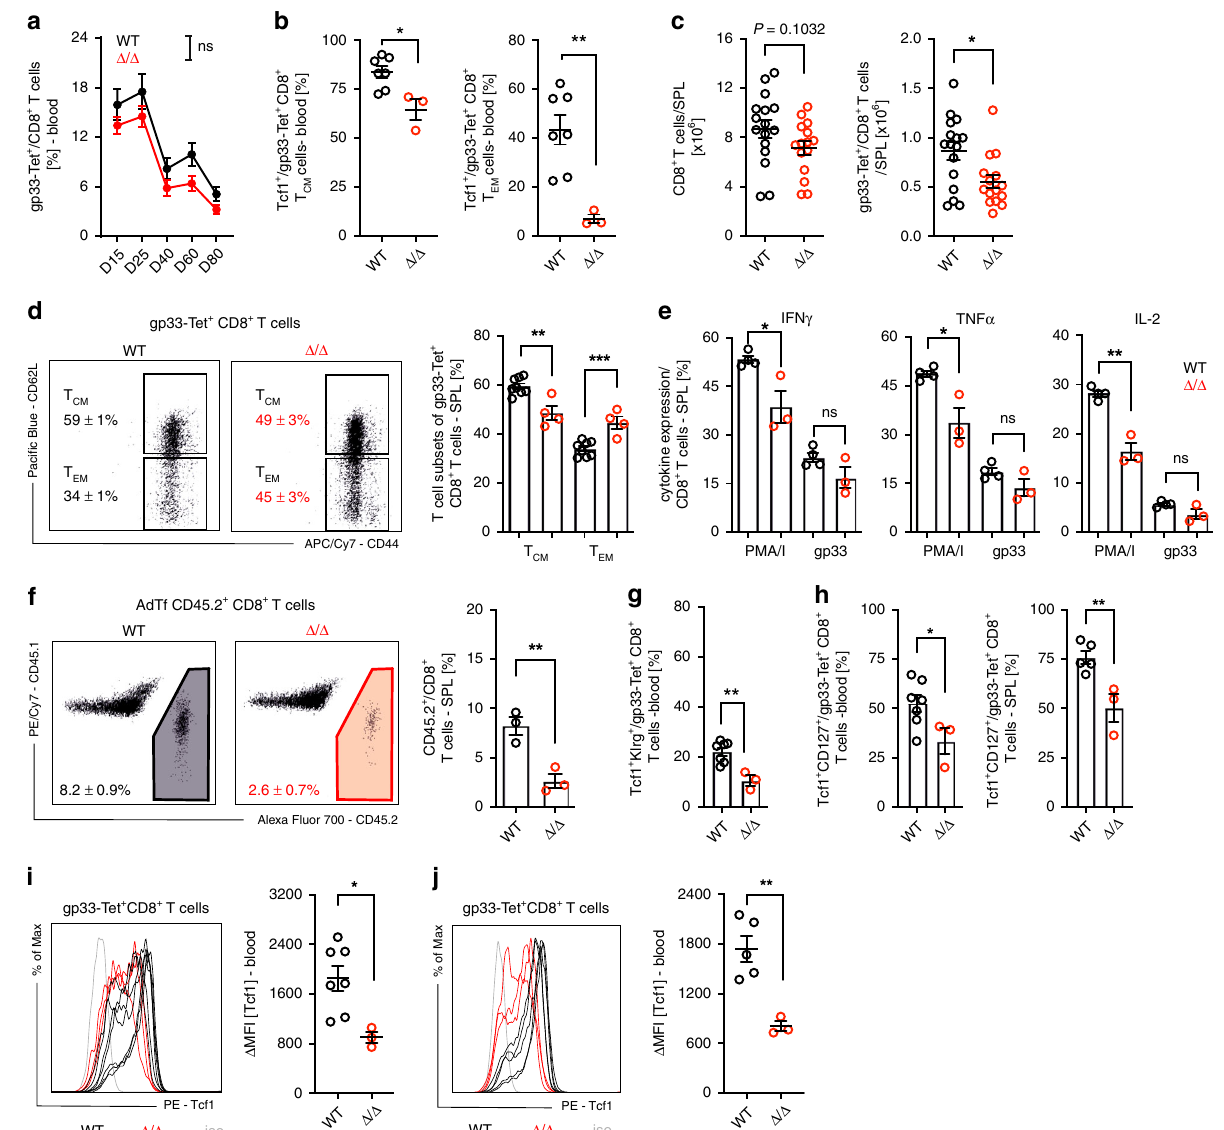
Fig. 2 Deletion of Tnik before priming impairs CD8 + T-cell memory formation. a Gp33-Tet + CD8 + T-cell frequency in blood of 200 pfu LCMV-WE- infected Tnik WT and Tnik Δ / Δ mice. b Frequency of Tcf1 expressing T CM (CD44 + CD62L + ) and T EM (CD44 + CD62L − ) gp33-Tet + CD8 + T cells in blood on day 30 p.i. Mice were killed on day 90 p.i. c CD8 + T cells and gp33-Tet + CD8 + T cells in the spleen. d Dotplots and bar graphs showing distribution of gp33-Tet + CD8 + T CM and T EM cell subsets in the spleen. e Frequencies of INF γ , TNF α , or IL-2-producing CD8 + T cells after re-stimulation with PMA/ Ionomycin or gp33 peptide. f AdTf of 3 × 10 4 FACS-puri fi ed gp33-Tet + CD8 + T cells from spleens of day 90 memory mice ( Cd45.2 + ) injected into congenic recipient mice ( Cd45.1 + ) prior to reinfection with 200 pfu LCMV-WE. Dotplots and bar graphs show relative distribution of endogenous vs AdTf CD8 + T cells 4 days p.i. Frequencies of Tcf1 + Klrg + and Tcf1 + CD127 + per gp33-Tet + CD8 + T-cell subsets in blood or spleen ( g ) 4 days or ( h ) 38 days post rVV-G2 re-challenge. i , j Histogram and Δ MFI of Tcf1 expressing gp33-Tet + CD8 + T cells in blood and spleen day 38 post re-challenge. Depicted: Tnik WT (black lines/circles), Tnik Δ / Δ (red lines/circles), isotype controls (iso; gray lines). a , d – f Data are representative for one out of two independent experiments ( n = 3 – 4), c for three pooled independent experiments ( n = 15 – 16), b , g – j for one experiment ( n = 3 – 7). Data are displayed as means ± SEM. Statistics: a two-way ANOVA, b – j two-tailed Student's t test, nonsigni fi cant P > 0.05, * P < 0.05, ** P < 0.01, *** P < 0.001. Also see Supplementary Fig. 2. Source data are provided as a Source Data fi